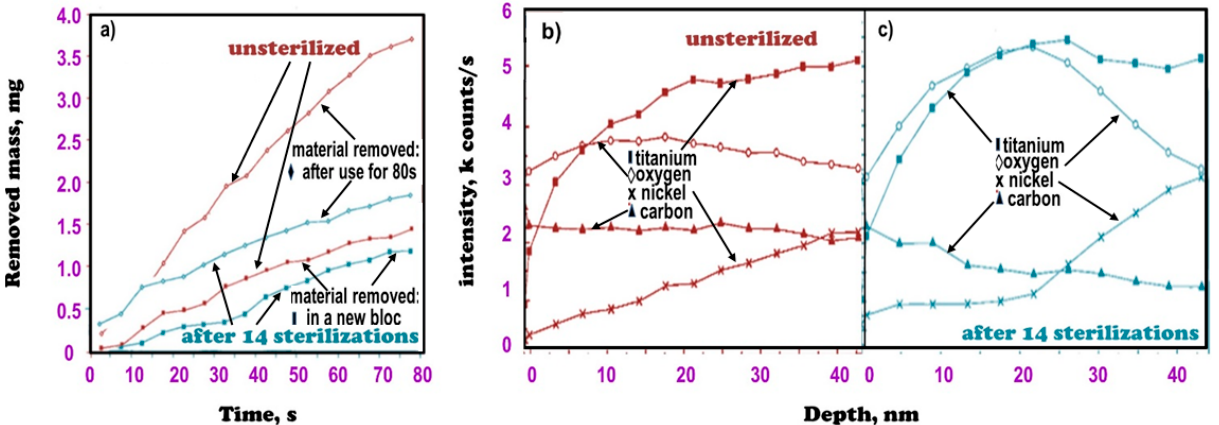
Figure 6. Properties of nitinol endodontic tools as delivered and after subsequent sterilization processes: ( a ) weight loss of the tool after drilling in a PMMA trial block with a simulated root canal used immediately after delivery or after repeated use for 80 s; ( b , c ) changes in the concentration of Ti, O, Ni, and C on the tool surface in the delivered condition ( b ) and after subsequent sterilization cycles ( c ).